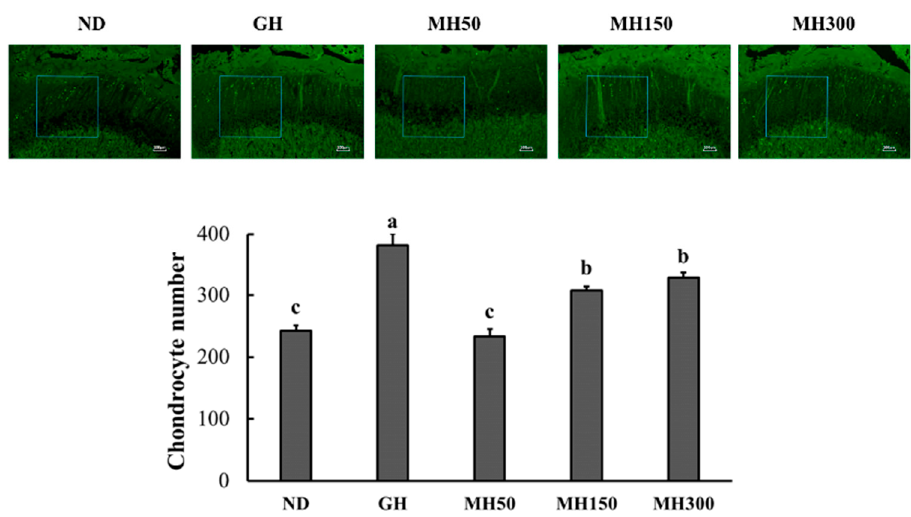
Figure 3. The effect of dietary administration of a mixture of H. japonicus (MH) on the number of chondrocytes in SD rats. ND (normal diet control): AIN93M diet; GH: AIN93M diet + intraperitoneal injection of 0.37 mg/kg b.w./day recombinant growth hormone; MH50: AIN 93G diet supplemented with MH 50 mg/kg b.w.; MH150: AIN 93G diet supplemented with MH 150 mg/kg b.w.; MH300: AIN 93G diet supplemented with MH 300 mg/kg b.w. Values are presented as means ± SD. Different letters indicate a significant difference with 𝑝 < 0.05, as determined by Duncan’s multiple range test.